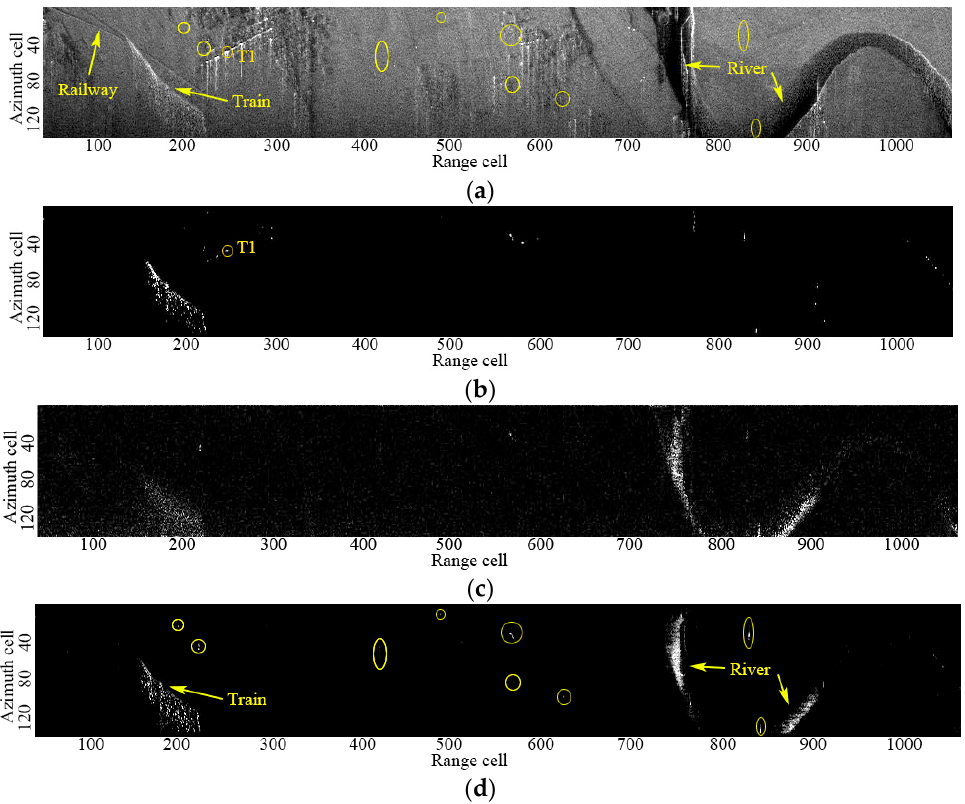
Figure 7. GMTI and CFAR results of different methods. ( a ) SAR image of the 1th channel; ( b ) Outputs of DPCA; ( c ) Outputs of ATI; ( d ) Outputs of RR-DPCA.